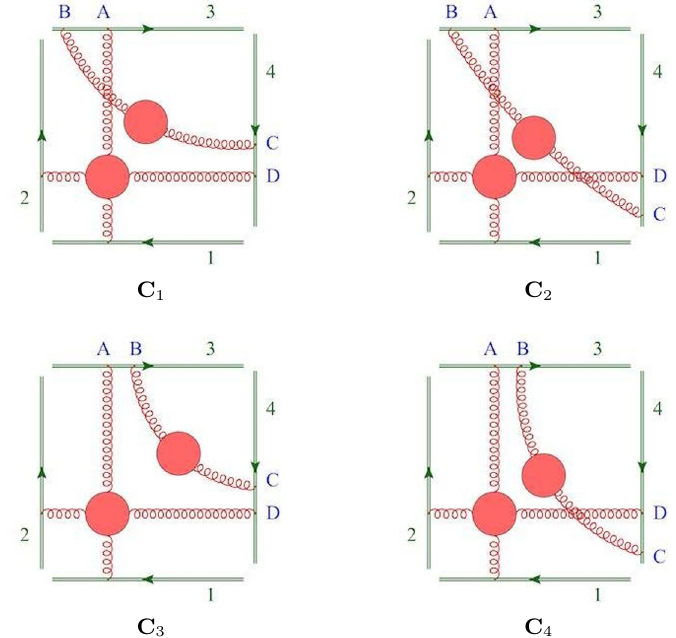
Figure 10. The four skeleton diagrams of the Cweb W (1 ; 0 ; 1)